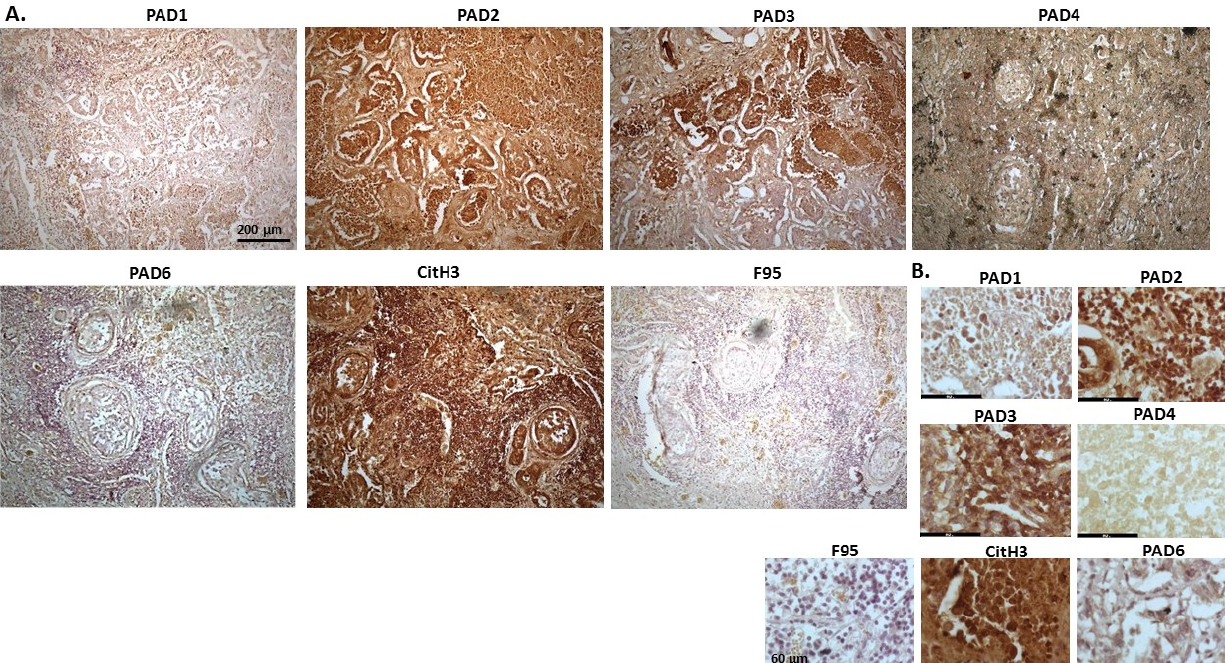
Figure 13. Cat, Pulmonary carcinoma (primary lung tumour suspected, with metastasis to heart); the sample is from a cadaver of 13-year old male cat. ( A ) Overview images for PAD1, 2, 3, 4, 6, CitH3 and F95 stainings of serial tissue sections; scale bar represents 200 μ m for all images; 10× objective. ( B ) Higher magnification shown for each staining from the images in ( A ); scale bar represents 60 µ m for all images; 40× objective.